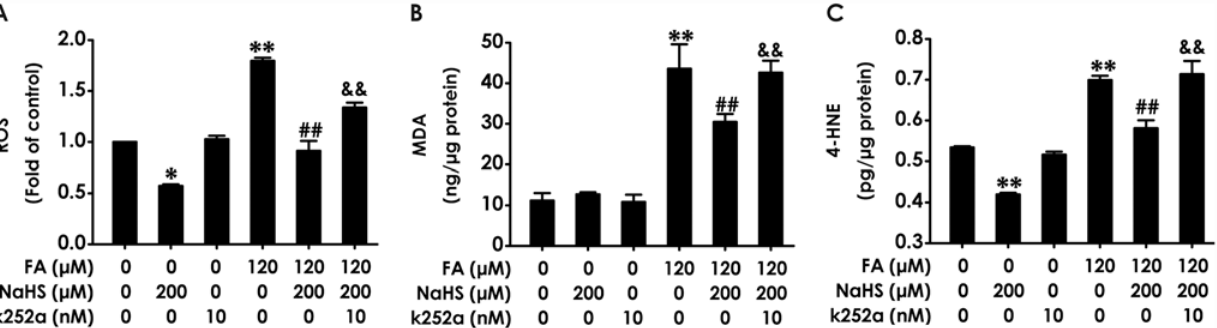
Fig 4. Effect of K252a on H 2 S-induced suppression in formaldehyde-mediated oxidative stress in PC12 cells. PC12 cells were preincubated with K252a (10 nM) for 30 min before pretreatment with NaHS (200 μ M) for 30 min, and then cotreated with formaldehyde (FA, 120 μ M) for 24 h. (A) The generation of intracellular ROS was measured by NBT reduction assay as described in “ Materials and methods. ” . (B) The level of MDA in PC12 cells was measured by MDA Elisa kits. (C) The level of 4-HNE in PC12 cells was measured by 4-HNE Elisa kits. Results were expressed as the mean ± S.E.M. of three independent experiments. * P < 0.05, ** P < 0.01, versus control group; ## P < 0.01, versus FA-treated alone group; && P < 0.01, versus cotreated with NaHS and FA